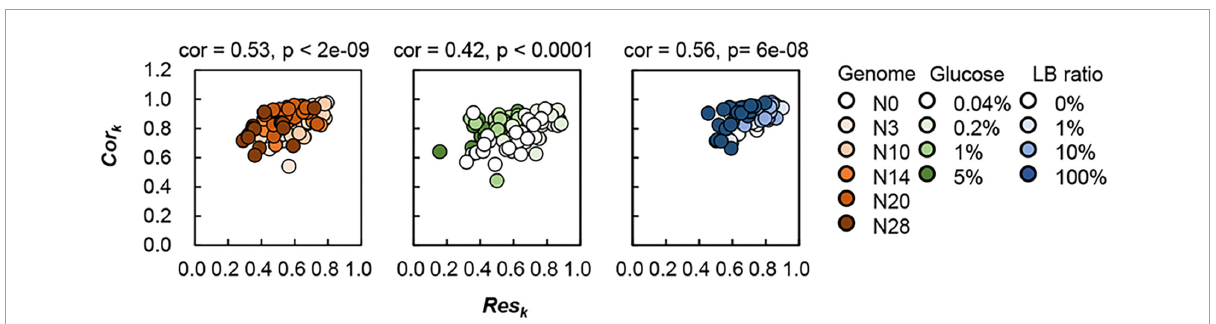
FIGURE6 Relationship between the Voronoi response and Voronoi correlation. Circles represent the plates. Gradations in orange, green and blue indicate the genome size from the wild type to the reduced ones ( N = 111), the concentration gradient of glucose in the minimal medium M63 ( N = 78) and the ratio gradient of LB in the mixed medium M63LB ( N = 80). Pearson’s correlation coefficients and the p -values are indicated.